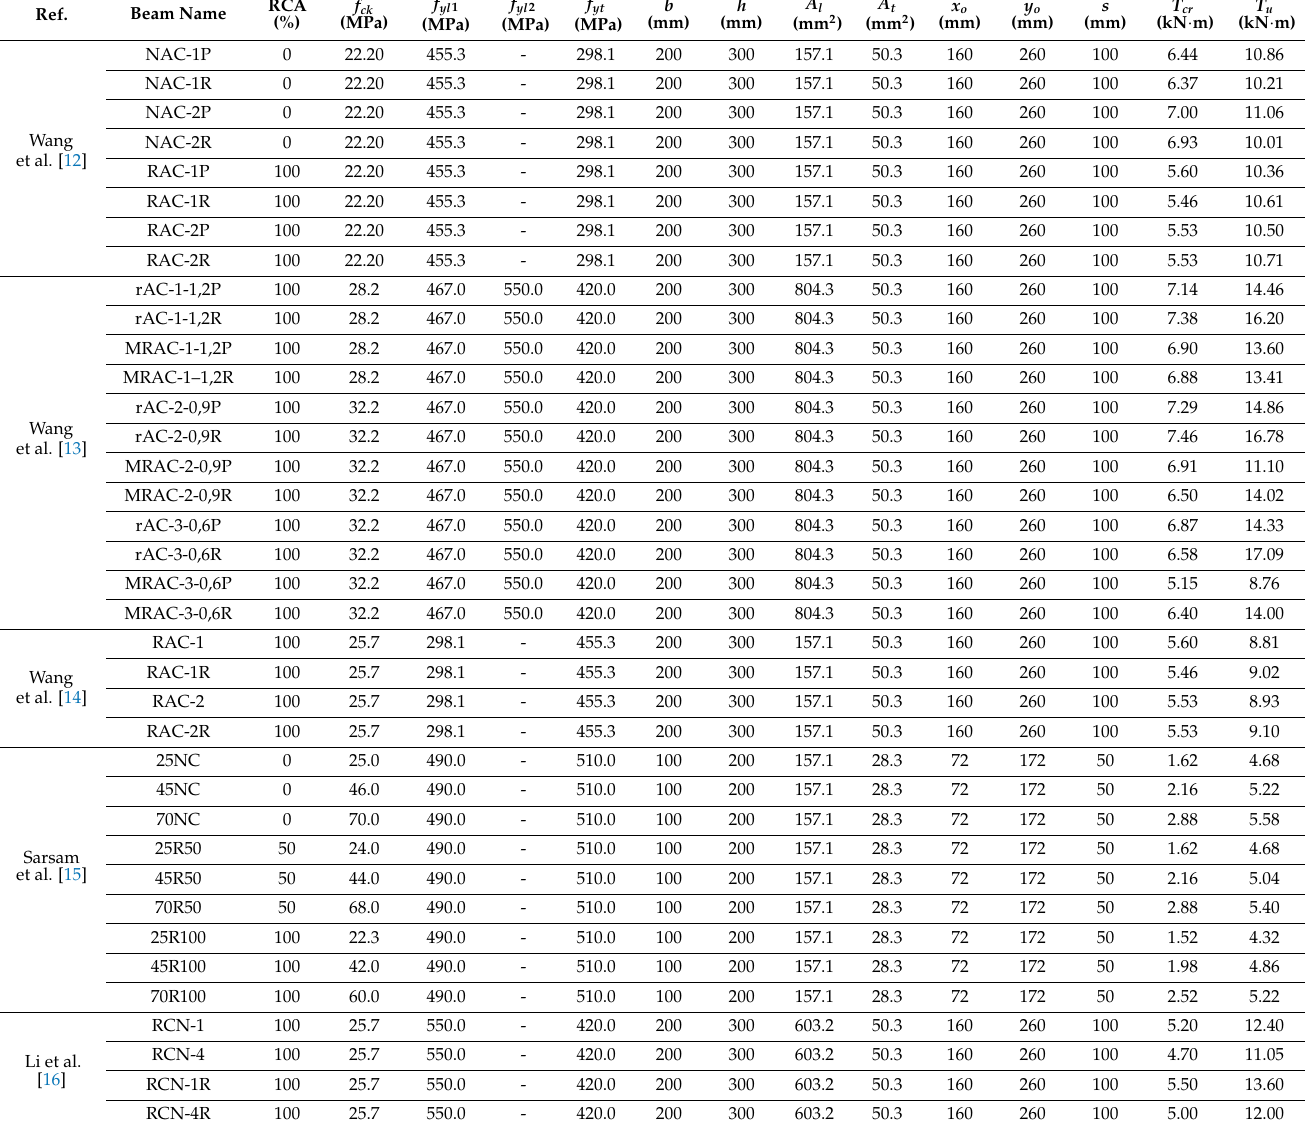
Table 1. Torsional database of RCA reinforced concrete beams (A total of 37